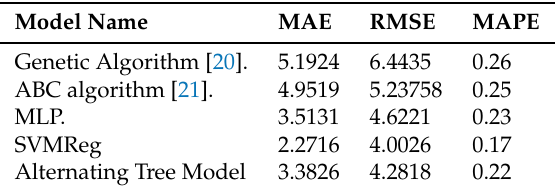
Table 5. Error rates for all